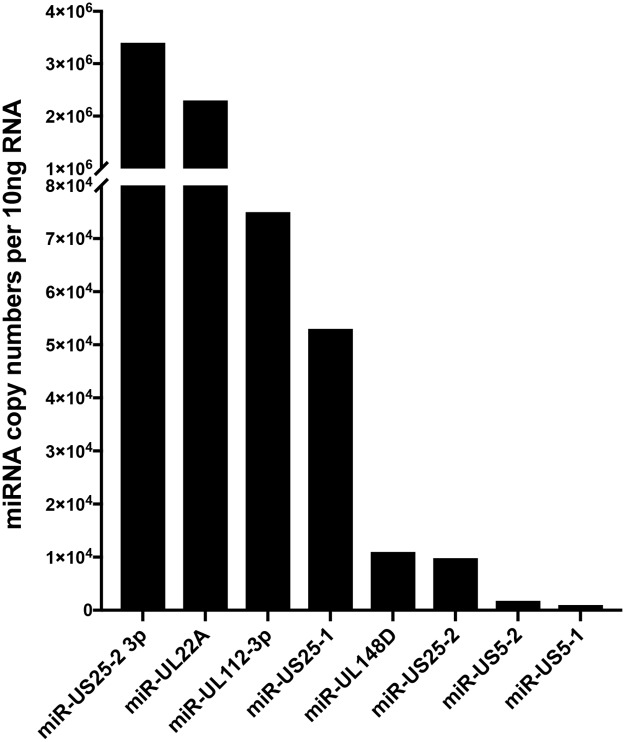
Expression of HCMV-encoded miRNAs in latently infected CD34+ HPCs.CD34+ HPCs were infected with WT HCMV TB40E for 48 hours, and then FACS-isolated for viable CD34+ GFP+ HPCs. Sorted cells were plated on stromal cell support for 12 additional days to establish HCMV latency, and HCMV miRNA levels were detected in 10ng RNA from infected cells by stem-loop RT-PCR for viral miRNAs.